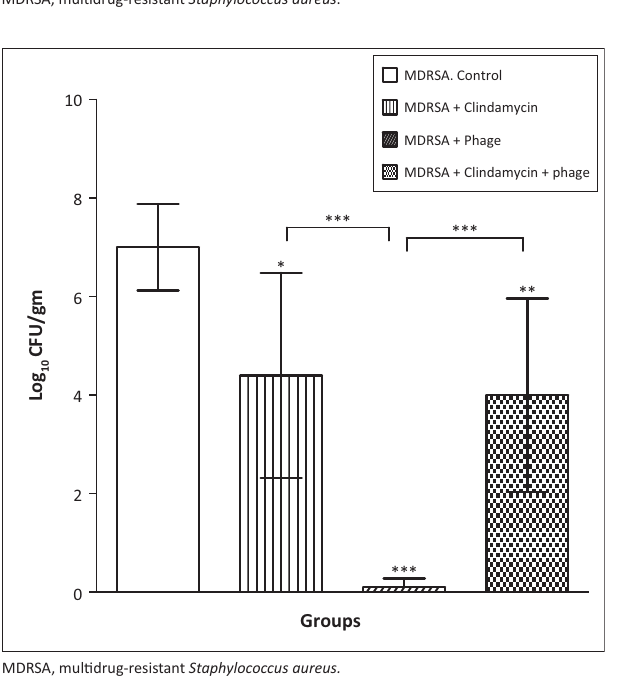
FIGURE 4: Mean bacterial count (mean Log CFU/gm ± SE) in lung tissue from 10 MDRSA-infected mice. Controls received no treatment, remaining infected mice were treated with clindamycin, phage, or a combination therapy (clindamycin plus phage). Each group had five mice. Levels of significance: * p < 0.05; ** p < 0.001; and *** p < 0.0001; each was compared with MDRSA